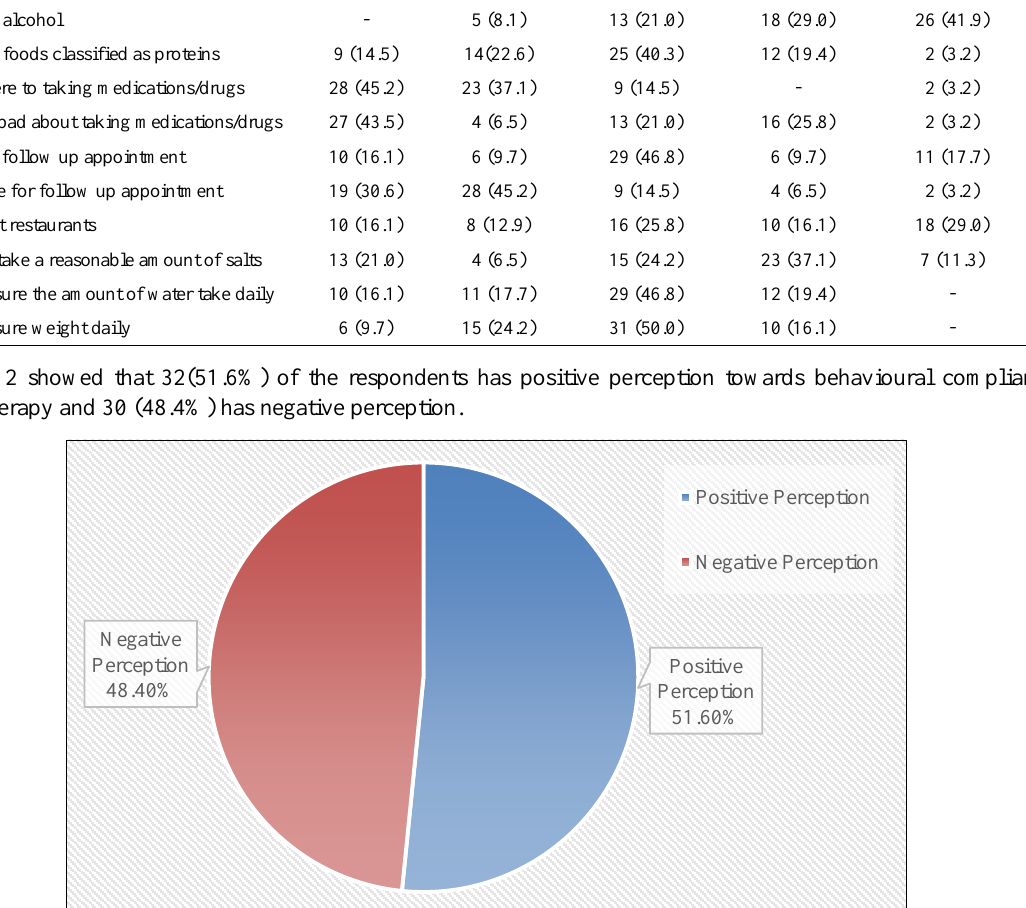
Table 2. Patients perceptions of compliance to dialysis therapy (n=62)